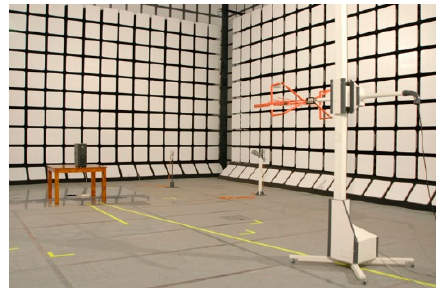
Figure 3. The anechoic chamber used for the EMSE tests.